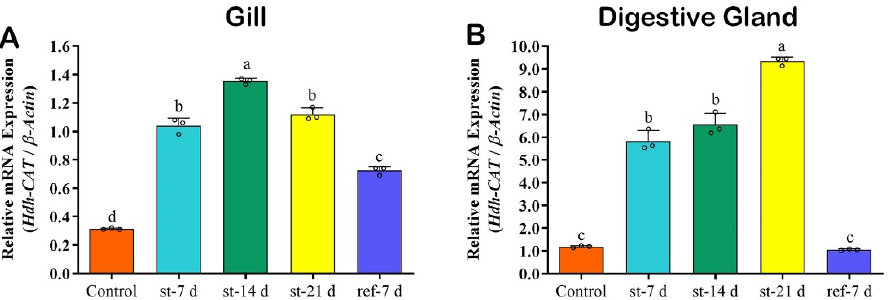
Figure 5. Hdh-CAT mRNA expression levels in starved and re-fed Pacific abalone at different time points. ( A ) Hdh-CAT mRNA expression level in gill of starved Pacific abalone. ( B ) Hdh-CAT mRNA expression level in DG of starved Pacific abalone. Different letters above the bars indicate significant differences ( p < 0.05).